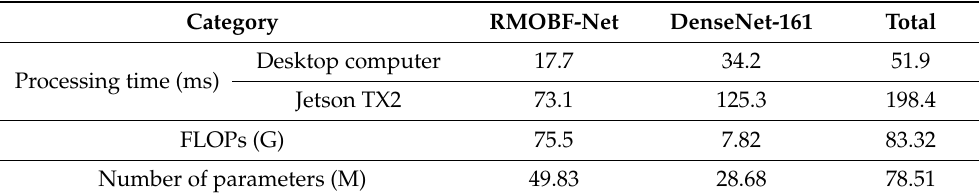
Table 10. Comparisons of processing time, FLOPs, and the number of parameters of the pro- posed method.